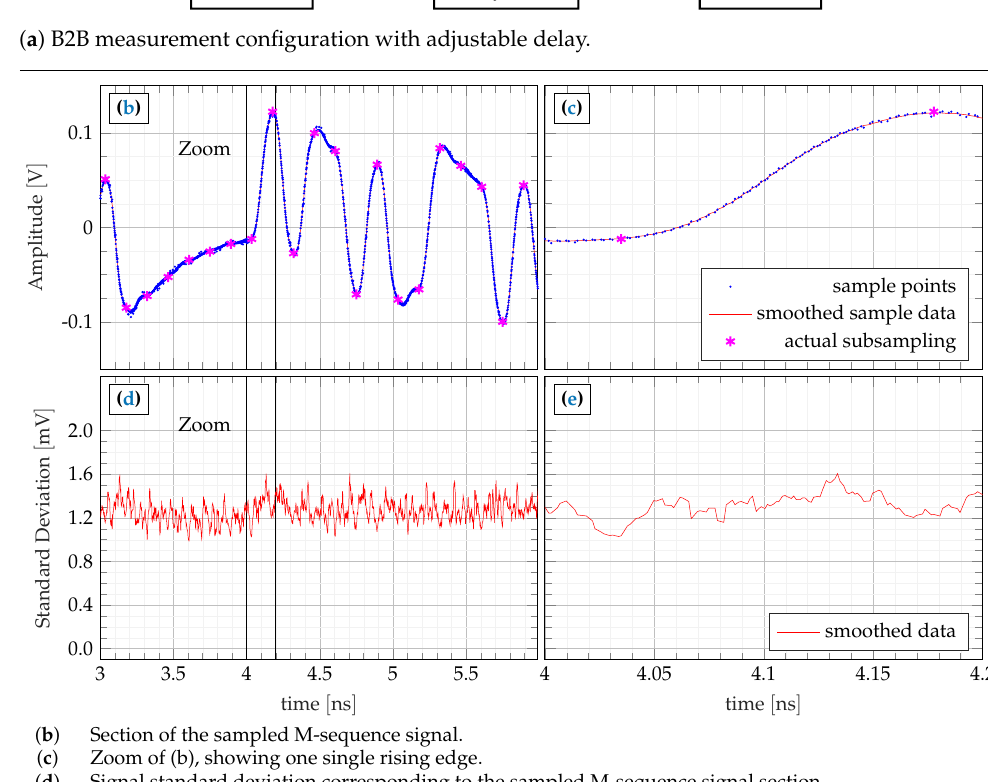
Figure 14. Jitter behavior of the M-sequence signal determined using stepwise incremental retardation (4ps delay steps) in back-to-back (B2B) operation: 9th-order M-sequence driven at f 0 = 7GHz, resulting oversampling at an equivalent sampling rate of f os =